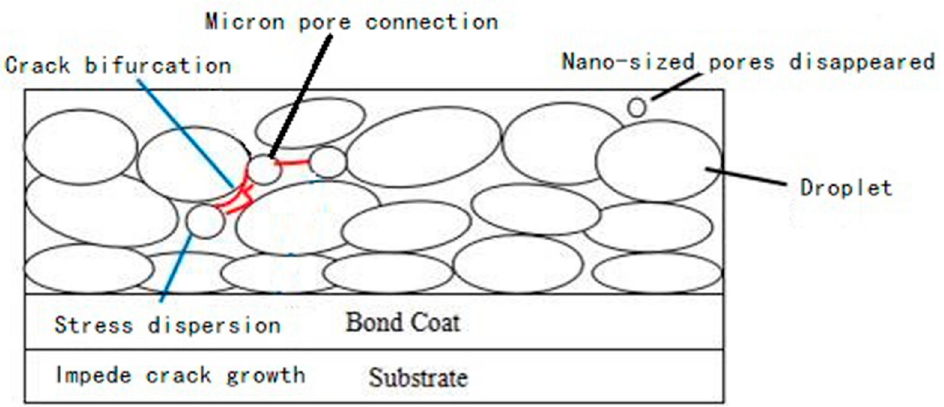
Figure 15. Schematic diagram of the multi-sized pore evolution mechanism.